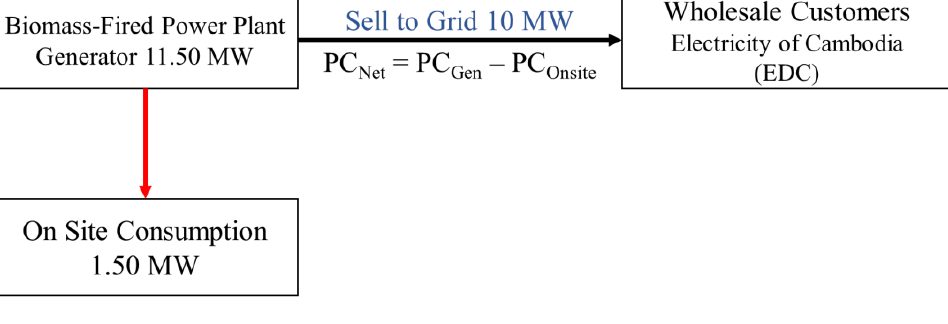
Figure 2. Block diagram of power flow model. Table 2. The specifications of generator [18].